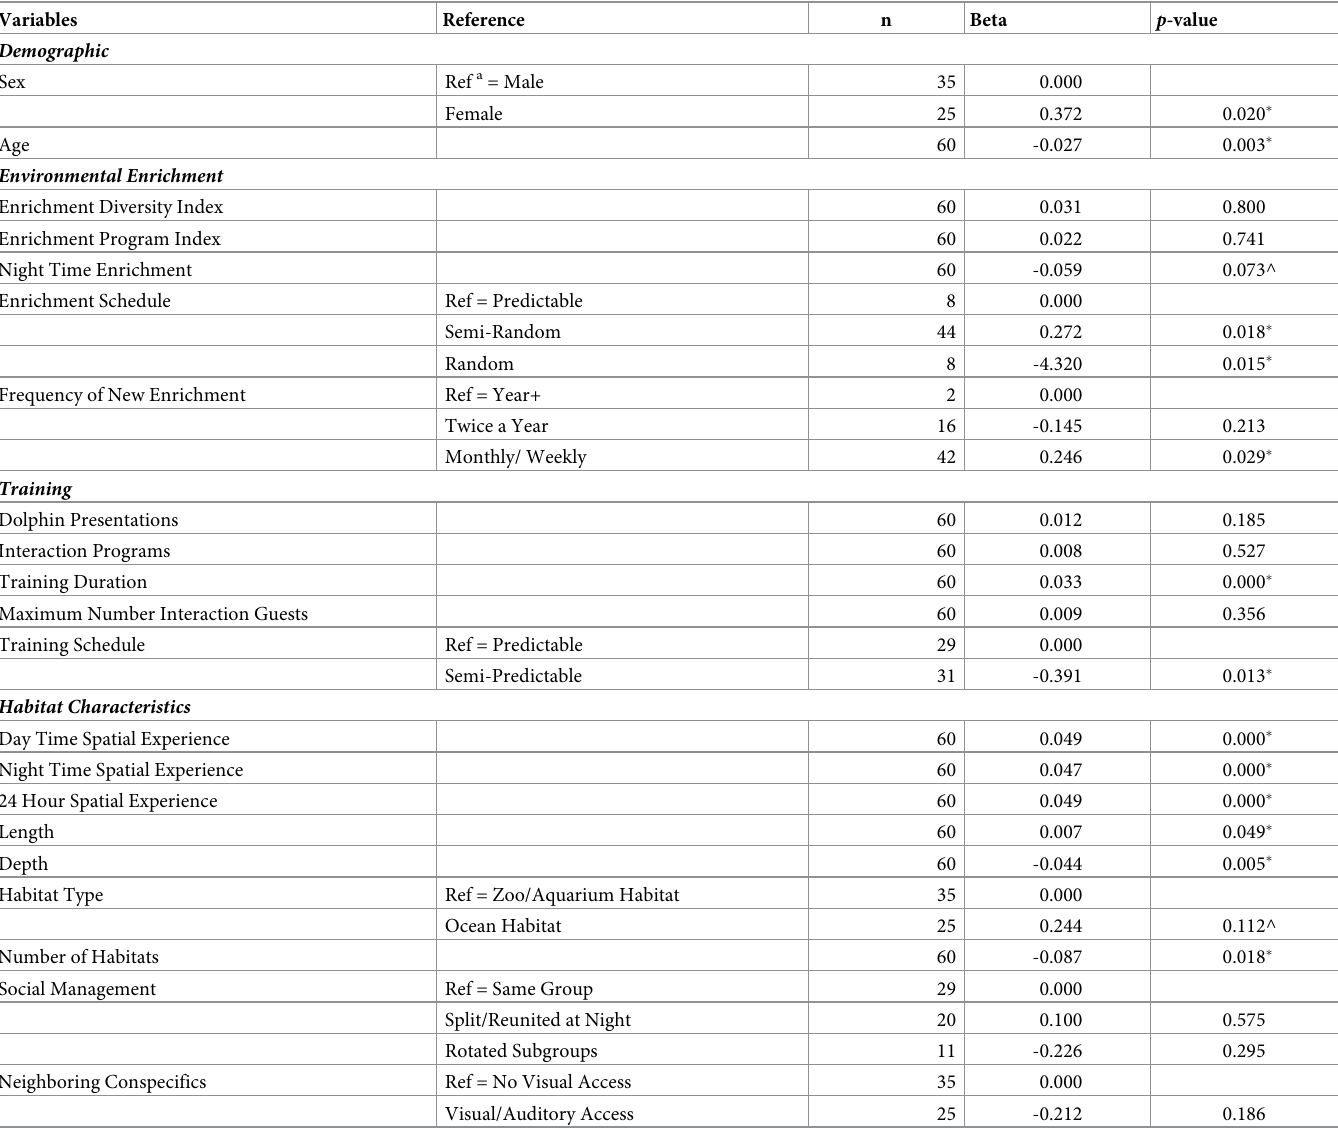
Table 2. Univariate correlations between ODBA and independent